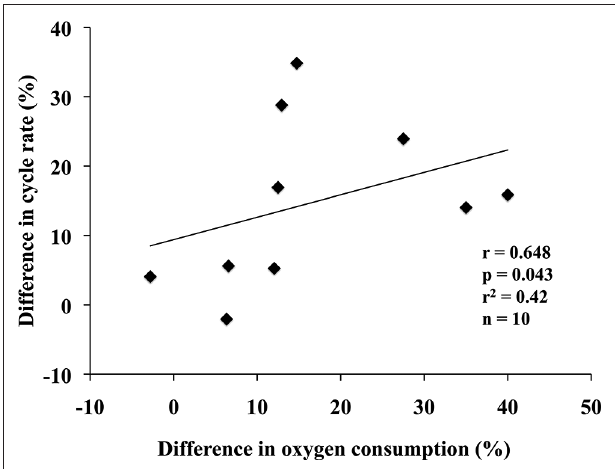
FIGURE 4 | Positive correlation between relative differences of “kneeing” and “knee-high” postures in oxygen consumption and cycle rate during stage three (34 percent of maximum sprint power